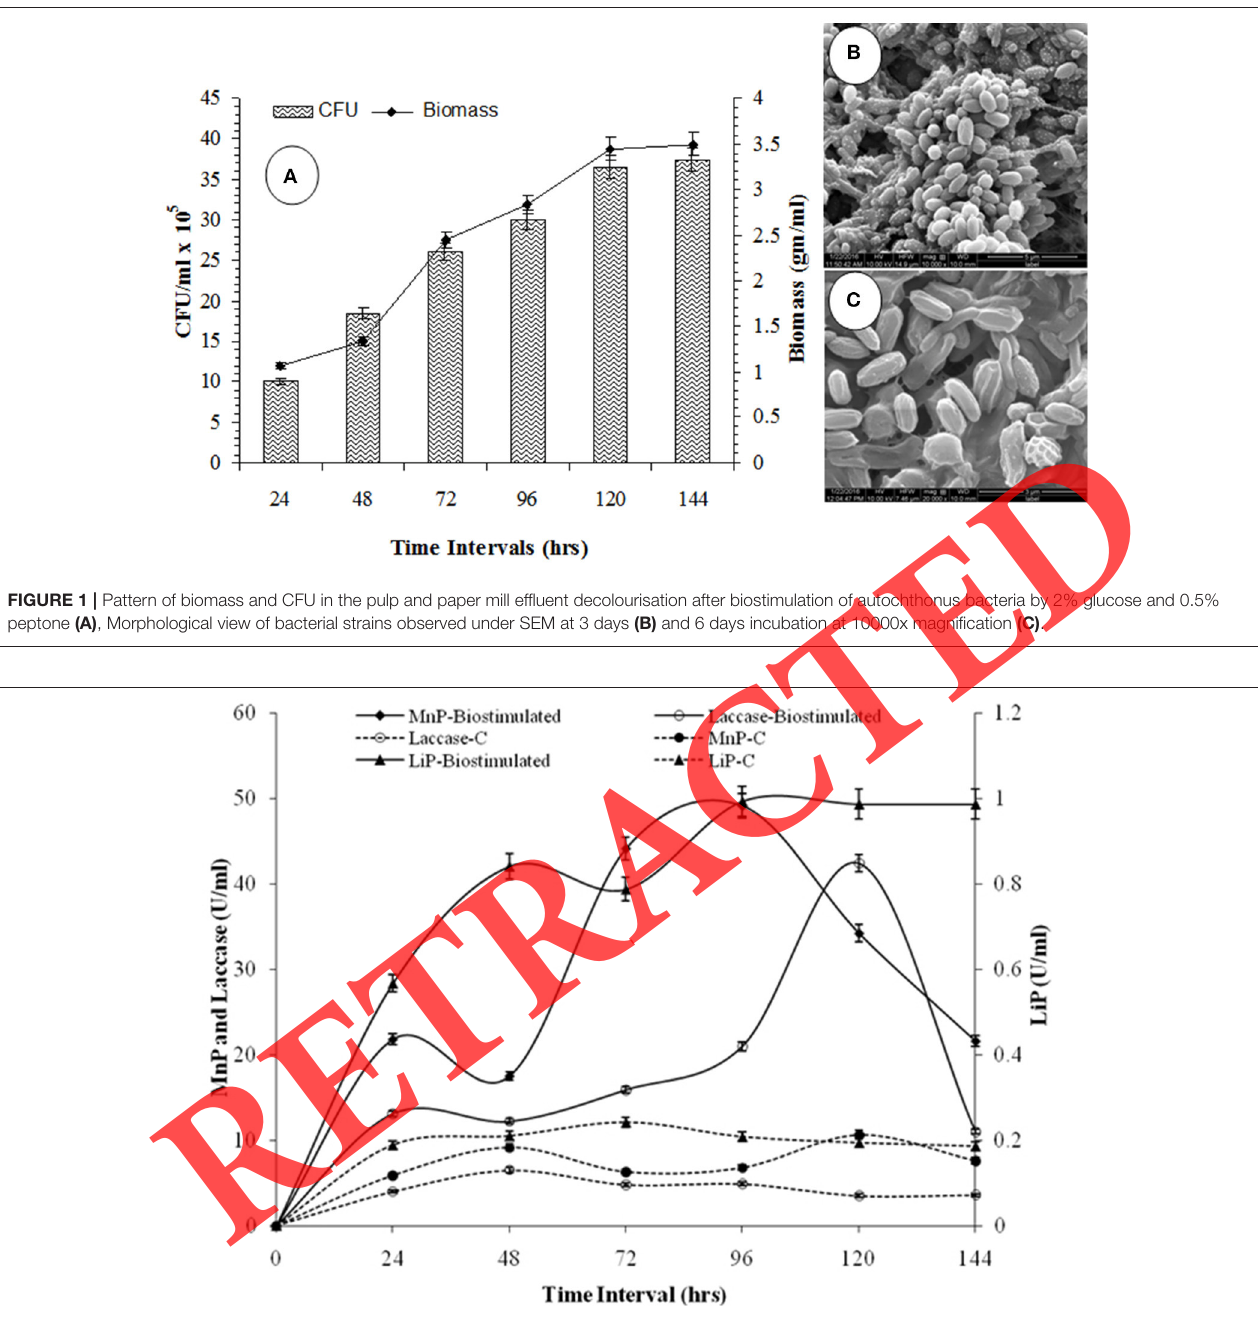
FIGURE 2 | Pattern of Ligninolytic enzyme during pulp and paper mill effluent decolourisation after Biostimulation. MnP, Manganese Peroxidase; LiP, Lignin Peroxidase.